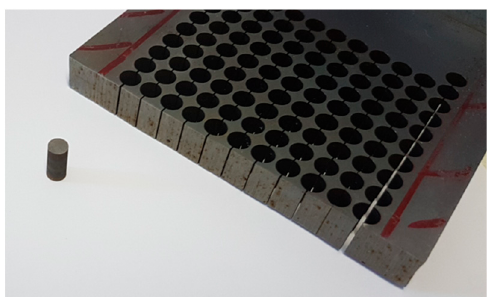
Figure 2. Semi-finished product and specimen produced by wire-cut EDM.